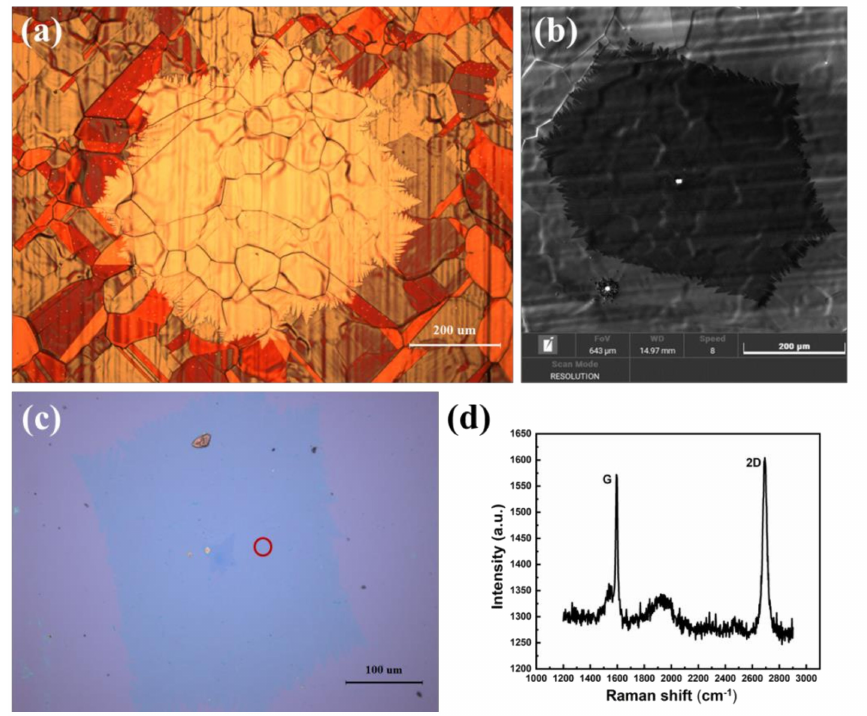
Figure 7. ( a ) Optical micrograph of single-crystal graphene on the back of the copper foil under 100-times magnification. ( b ) SEM image of single-crystal graphene domains on the copper foil. ( c ) Optical micrograph of single-crystal graphene transferred onto silicon dioxide grown on Si wafers under 100-times magnification. ( d ) The Raman spectra of the single-crystal graphene transferred onto the silicon dioxide grown on Si